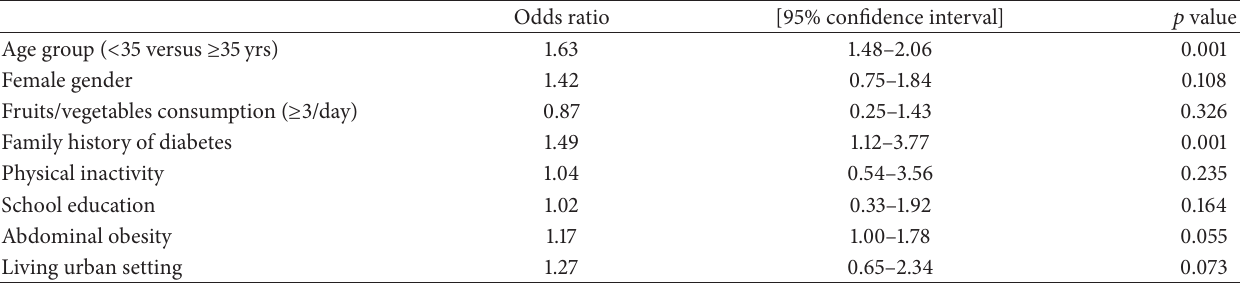
Table 3: Adjusted association between diabetes and risk factors (multivariate regression analysis). Odds